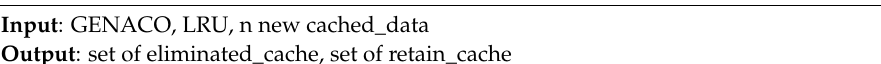
Algorithm 1 Pseudo-code the proposed LRU-GENACO